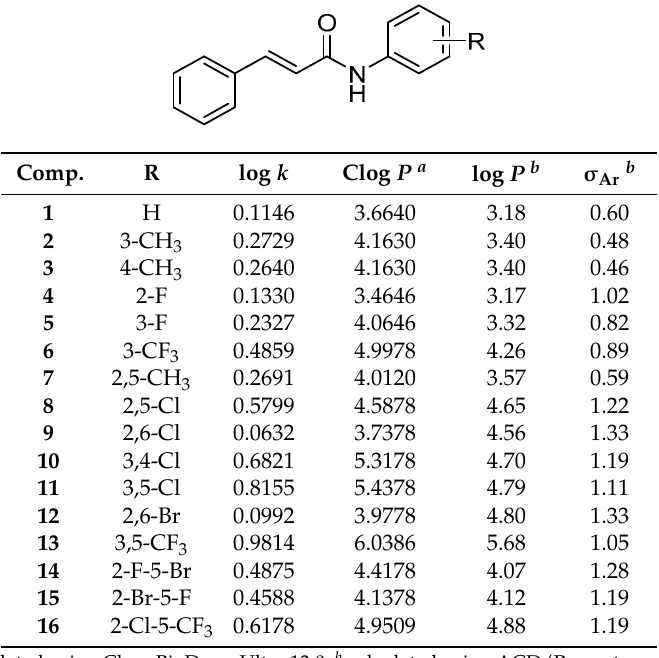
Scheme 1. Synthesis of (2 E )- N -aryl-3-phenylprop-2-enamides 1 – 16 . Reagents and conditions: (a) PCl 3 , chlorobenzene, and MW. Table 1. Structure of ring-substituted (2 E )- N -aryl-3-phenylprop-2-enamides 1 – 16 , experimentally determined values of lipophilicity log k , calculated values of log P /Clog P , and electronic Hammett’s σ parameters.